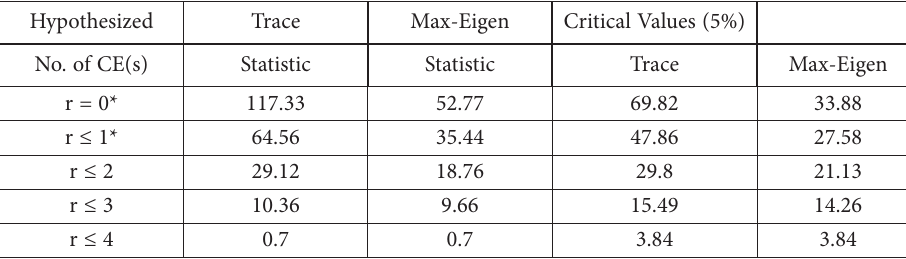
Table 3. Johansen-Juselius Cointegration test results with (lFIRMS) (source: authors’ calculation) Hypothesized Trace Max-Eigen Critical Values (5%) No. of CE(s) Statistic Statistic Trace Max-Eigen